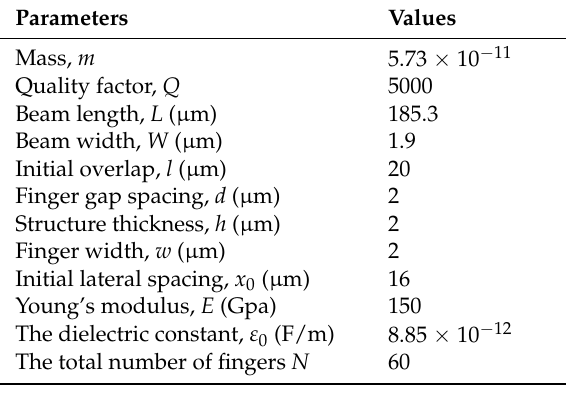
Figure 9. Natural frequency compared with experiment results in Reference [23].